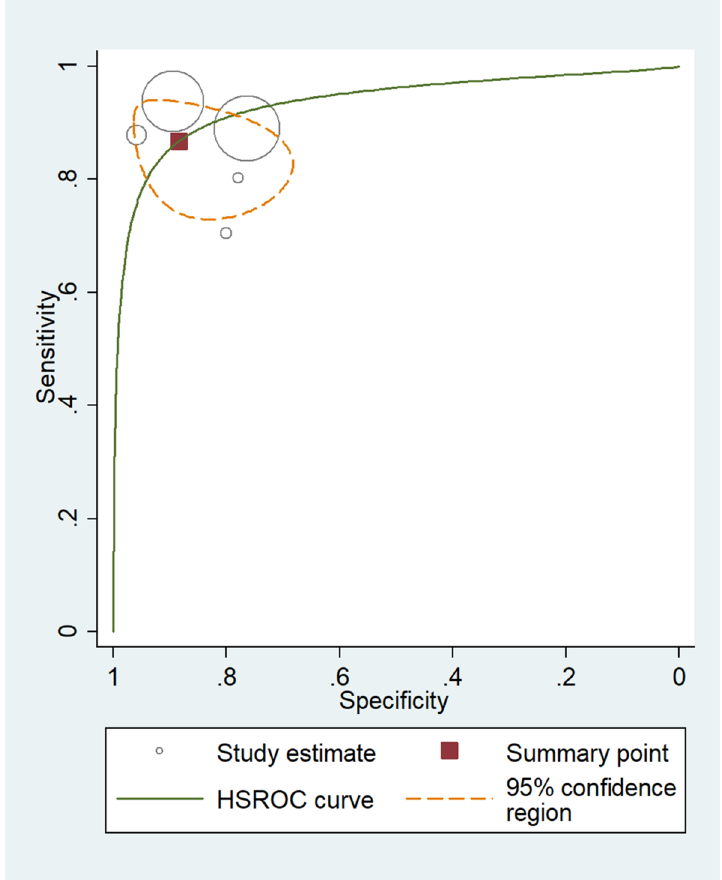
Figure 5. Diagnostic performance of screening using rats compared to ZN microscopic analysis, LED FM, and culture. The size of circles indicates the number of patients in a single study. The dark red square shows the sensitivity and specificity summary. The dashed line indicates the 95% confidence region. Meta-analysis summary of the six studies (five circles are seen, because two studies are exactly overlapping) shows that the sensitivity of rat screening was 86.7% [95% CI 80.4–91.2%] and specificity was 88.4% [95% CI 79.7–93.7%]. The summary for positive LR + and LR − was 7.47 [95% CI 4.05–13.8] and 0.15 [95% CI 0.1–0.23], respectively. The diagnostic odds ratio was 49.8 [95% CI 19.5–127]. According to the AUC 0.93 [95% CI: 0.91–0.95] value the test was classified as excellent. HSROC, hierarchical summary receiver-operating characteristic; AUC, area under the